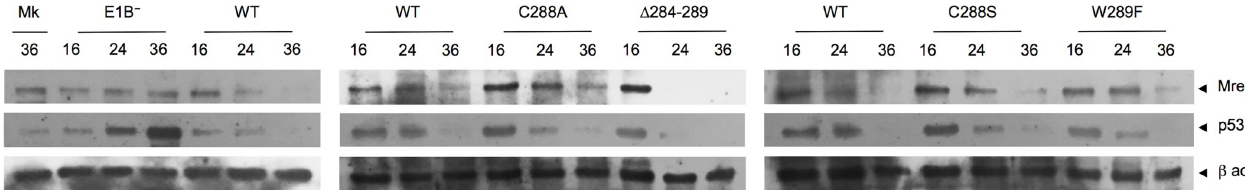
Fig 4. E1B 55k RNP substitutions do not impair degradation of Mre11 and p53. HFF cells were infected and harvested at 16, 24 and 36 hpi. Total protein extracts were obtained and Western blot assays were performed employing anti-Mre11 (Novus Biologicals) and anti-p53 DO1 (Santa Cruz Biotechnology) antibodies. β actin (Santa Cruz Biotechnology) was used as the loading